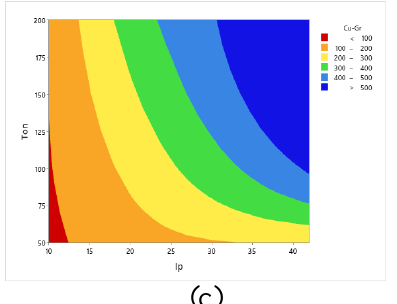
Fig. 4. Contour plots for MRR; (a) copper electrode, (b) graphite electrode, and (c) copper-graphite electrode.